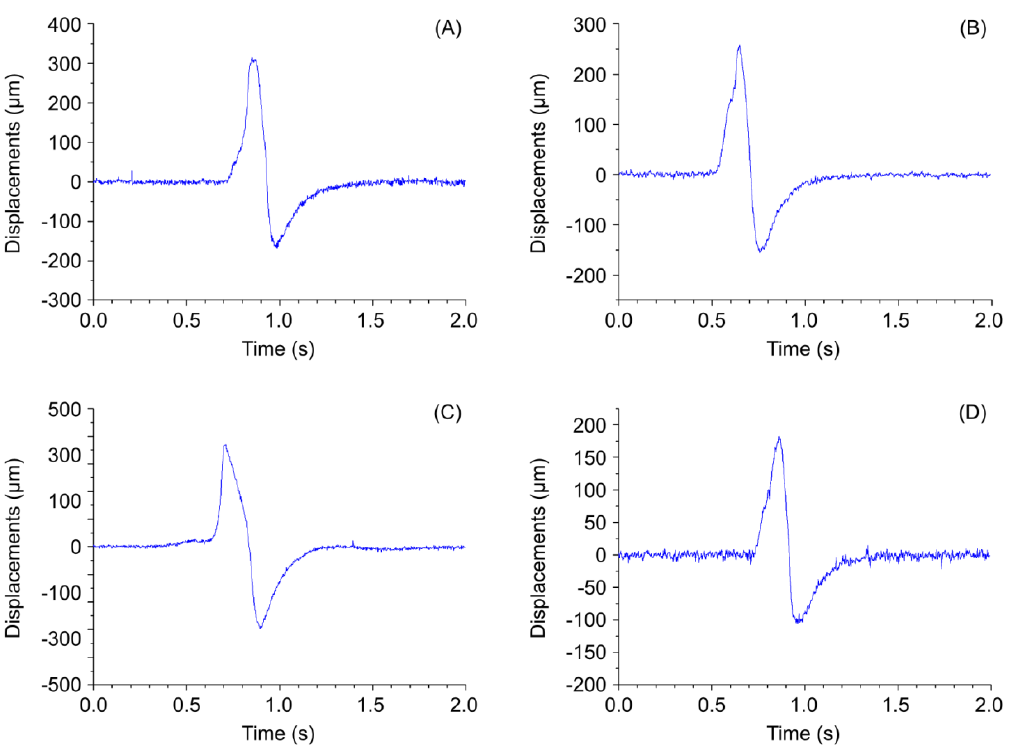
Figure 6. Plots of registered data for different values of pressure applied to artificial blood flow system: ( A ), ( C ) 120 mmHg; ( B ), ( D ) 140 mmHg ((A), (B) artificial blood; (C), (D)